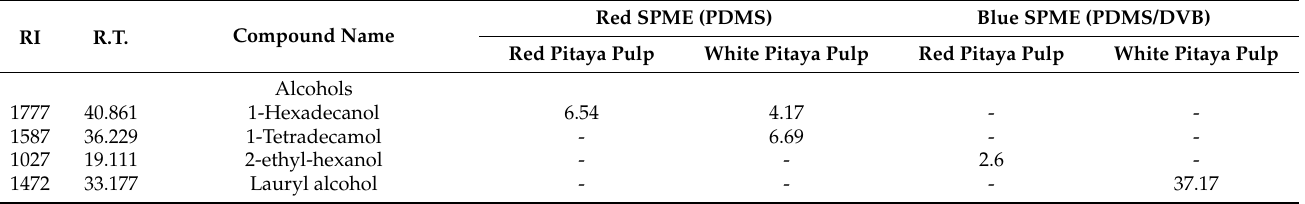
Table 3. Volatile profiles of red and White-fleshed pulp pitaya species using red and blue SPME fibers by HS-SPME/GC/MS techniques. Retention Time (R.T) percent